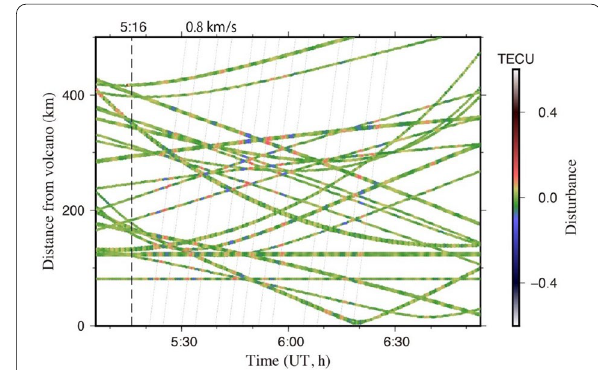
Fig. 4 Short period TEC disturbances (positive/negative changes expressed in red/blue) as functions of time (horizontal axis) and the distance from the Fukutoku-Okanoba volcano (vertical axis) for all the satellite–station pairs showing the eruption signatures. Thin lines, connecting points of clear positive anomalies, have a slope corresponding to the acoustic wave propagation speed (0.8 km/s)